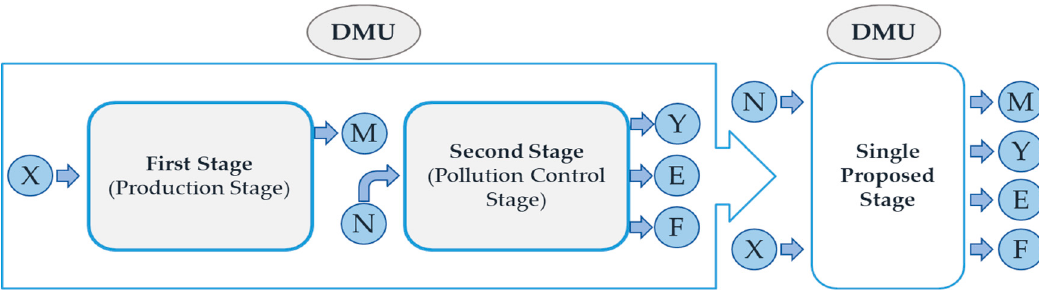
Figure 4. Conversion of the two-stage model to the single-stage standard model.